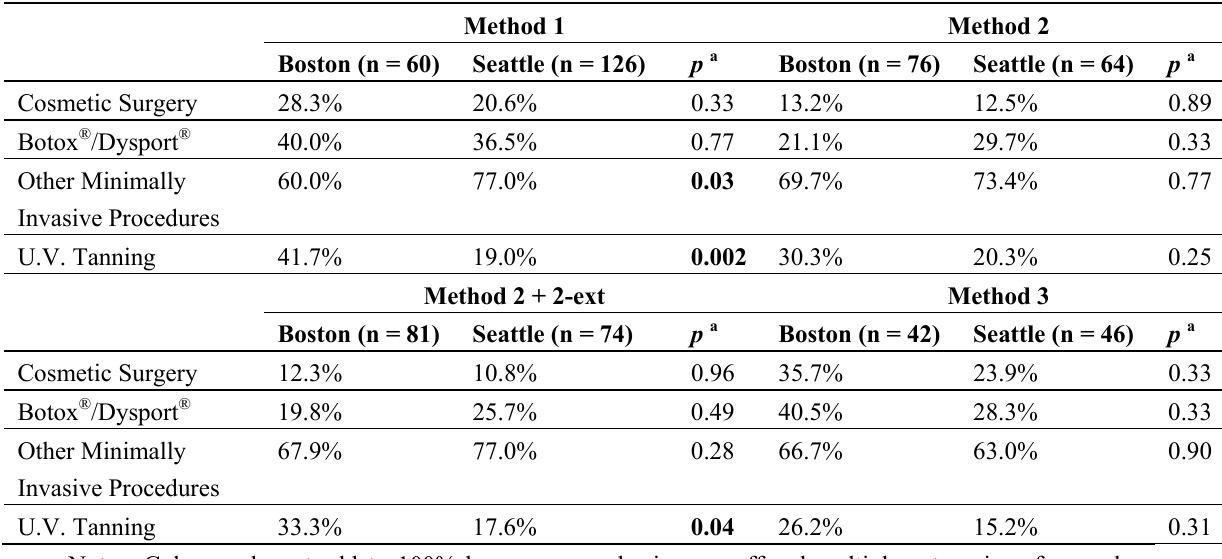
Table 3. Business identification and validation: Distribution of cosmetic-procedure types among all confirmed businesses for each city and each